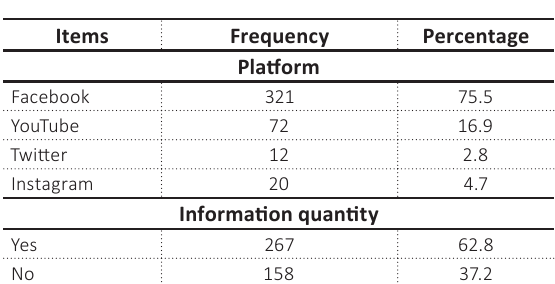
Table 2. Respondents’ usage rate of social network sites